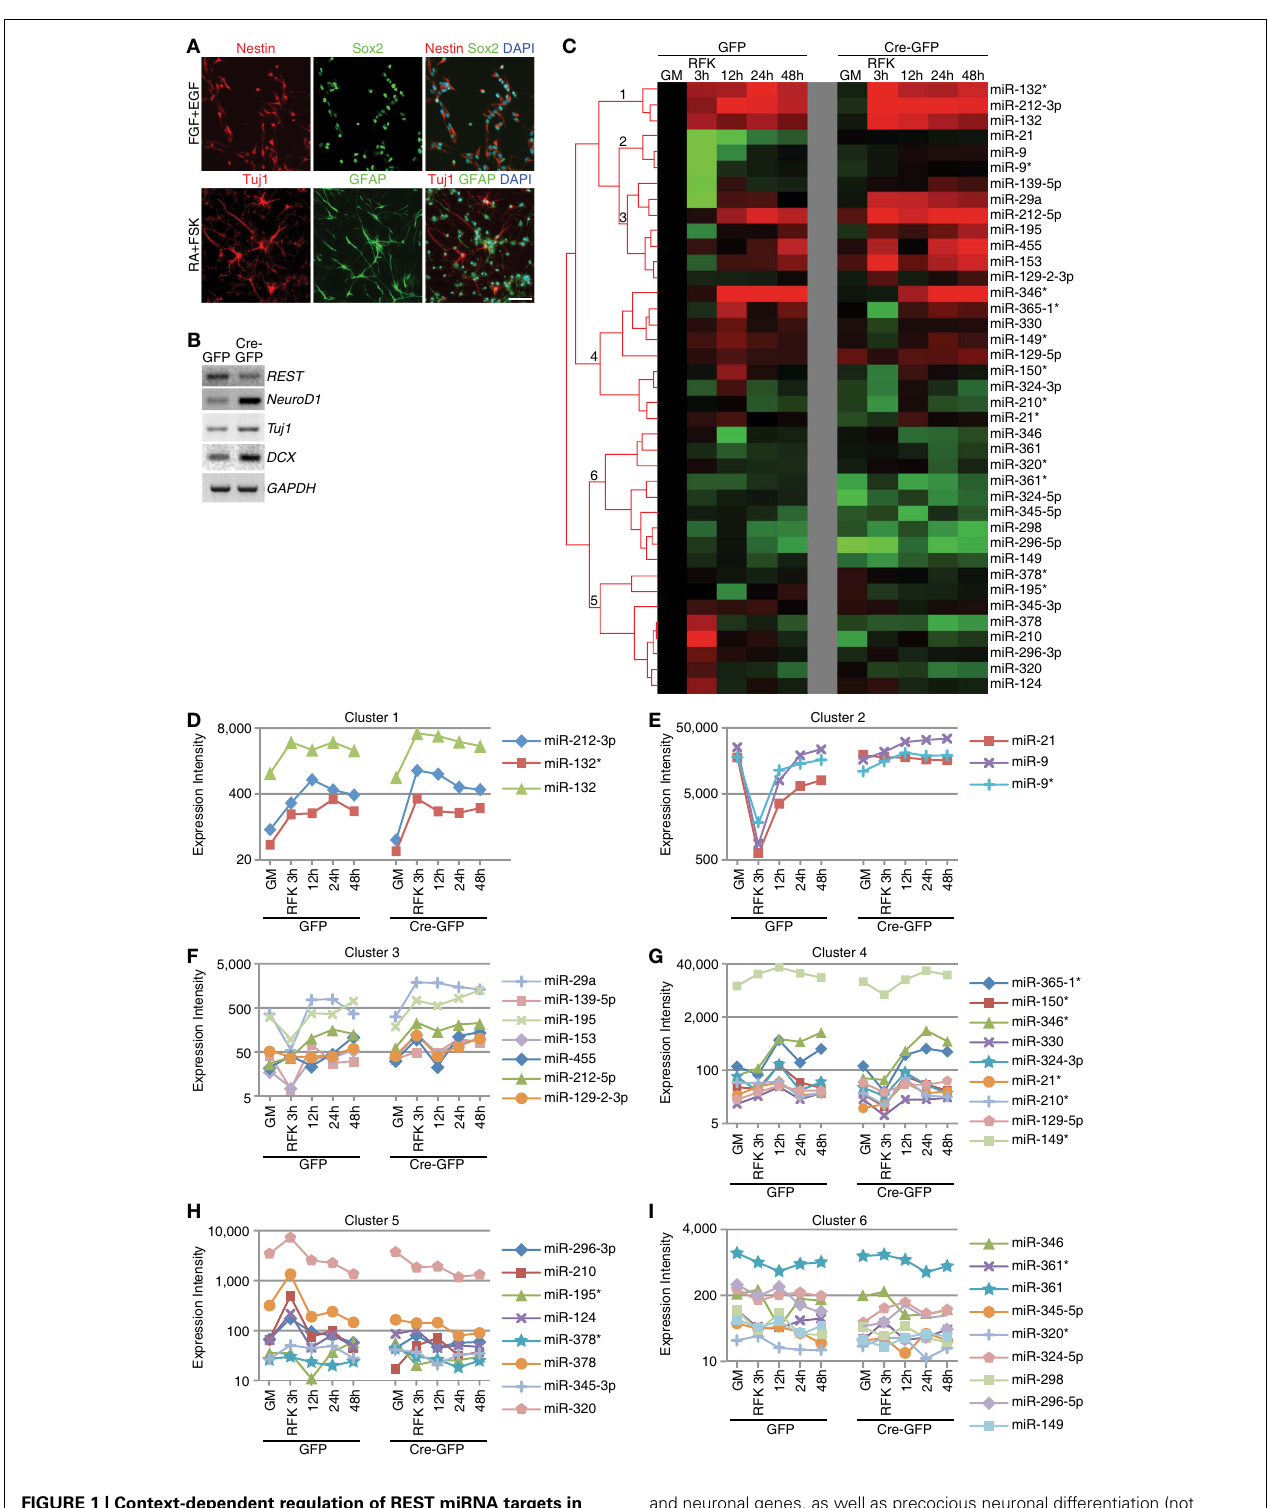
FIGURE 1 | Context-dependent regulation of REST miRNA targets in mouse NSCs. (A) Successful derivation of multipotent REST cKO NSCs was confirmed using NSC markers (Nestin and Sox2), neuronal (Tuj1) and astrocytic markers (GFAP). Scale bar: 40 μ m. (B) REST deletion by Ad-Cre-GFP viral infection in vitro resulted in upregulation of its target genes